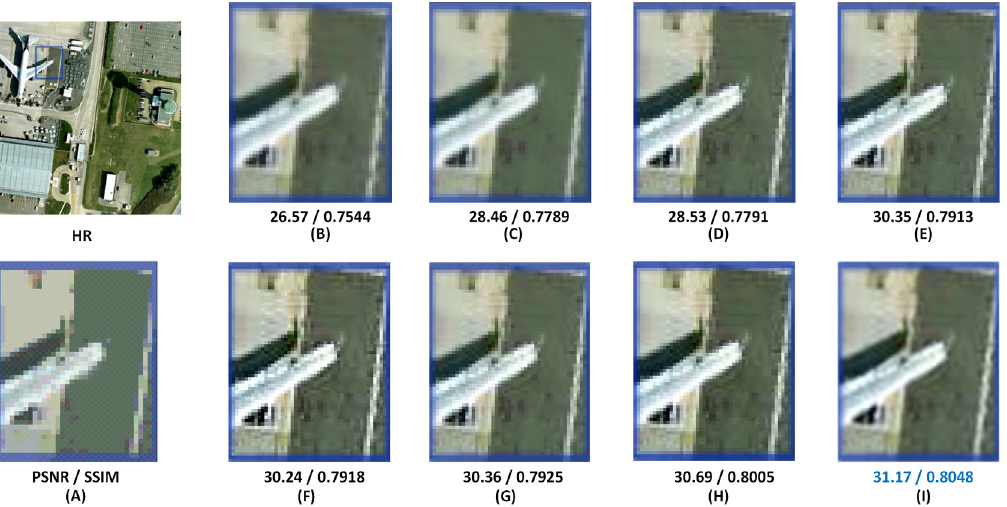
Figure 13. Comparison of values with different algorithms on the 3× “P0283” airport picture: ( A ) LR; ( B ) bicubic; ( C ) SRCNN; ( D ) FSRCNN; ( E ) VDSR; ( F ) EDSR; ( G ) LapSRN; ( H ) SRGAN; ( I ) ours.